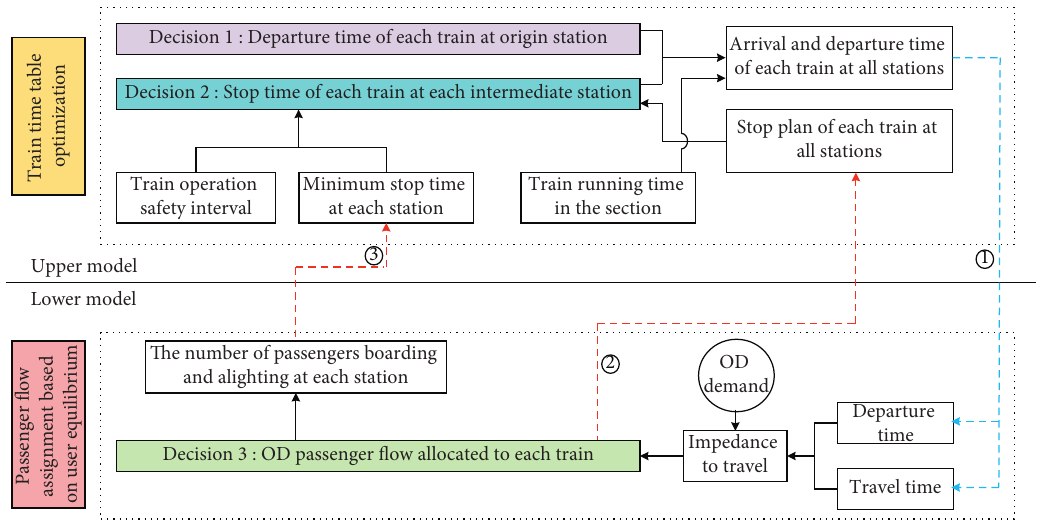
Figure 2: Feedback relationship between upper and lower models.